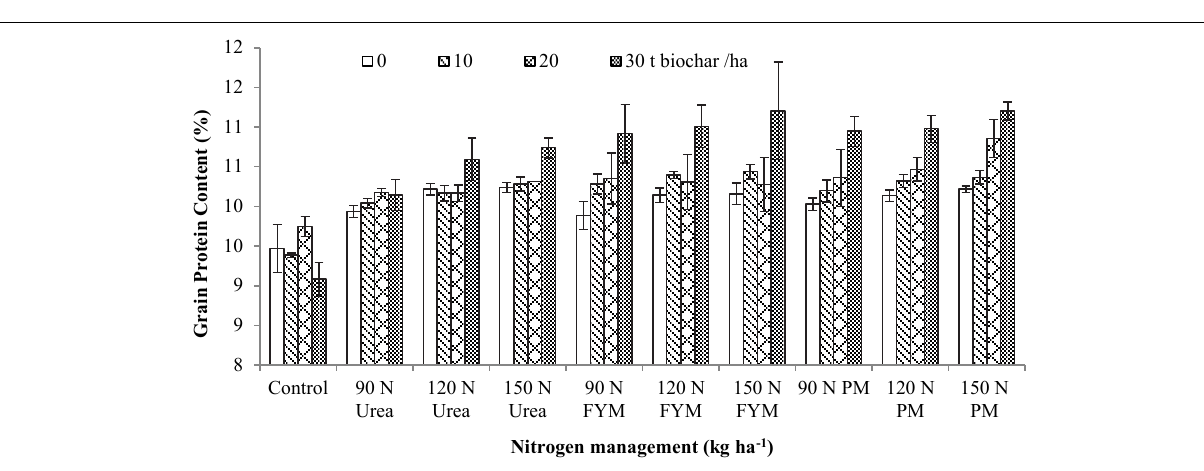
FIGURE 7 | Interactive effect biochar and N levels applied from different sources on the grain protein content of wheat. Bars on graph denote SE of mean ( n = 3). FYM, farmyard manure; PM, poultry